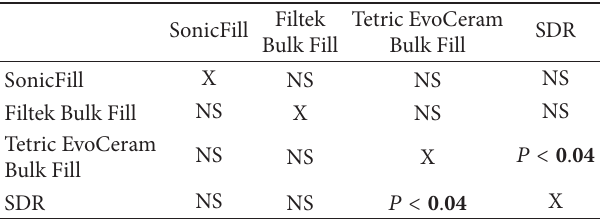
Figure 3: All restorations without microleakage (discoloration). Table 3: Comparison of significant differences between pairs of composites.